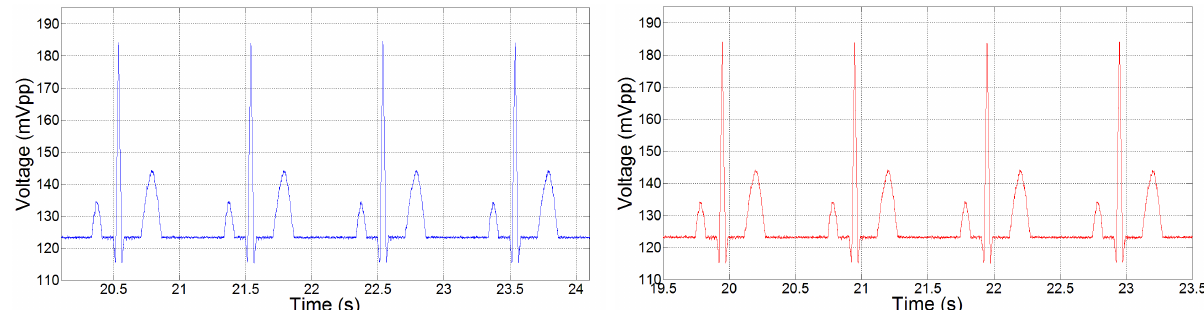
Figure 9. Measured ECG readings (scaled by amplifier gain) when using a direct power supply of 1.8 V (shown on left ) and a regulated 1.8 V from the power management chip (shown on right ) using a 1 mVpp Lead-I at 60